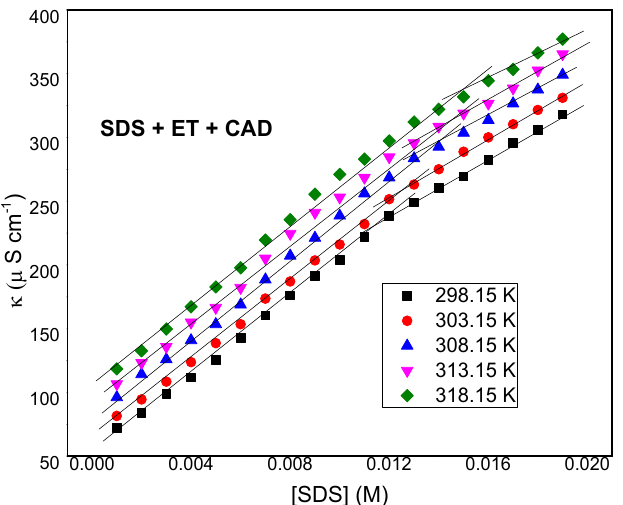
Figure 3. Specific conductance of SDS in cinnamaldehyde + ethanol at different temperatures .